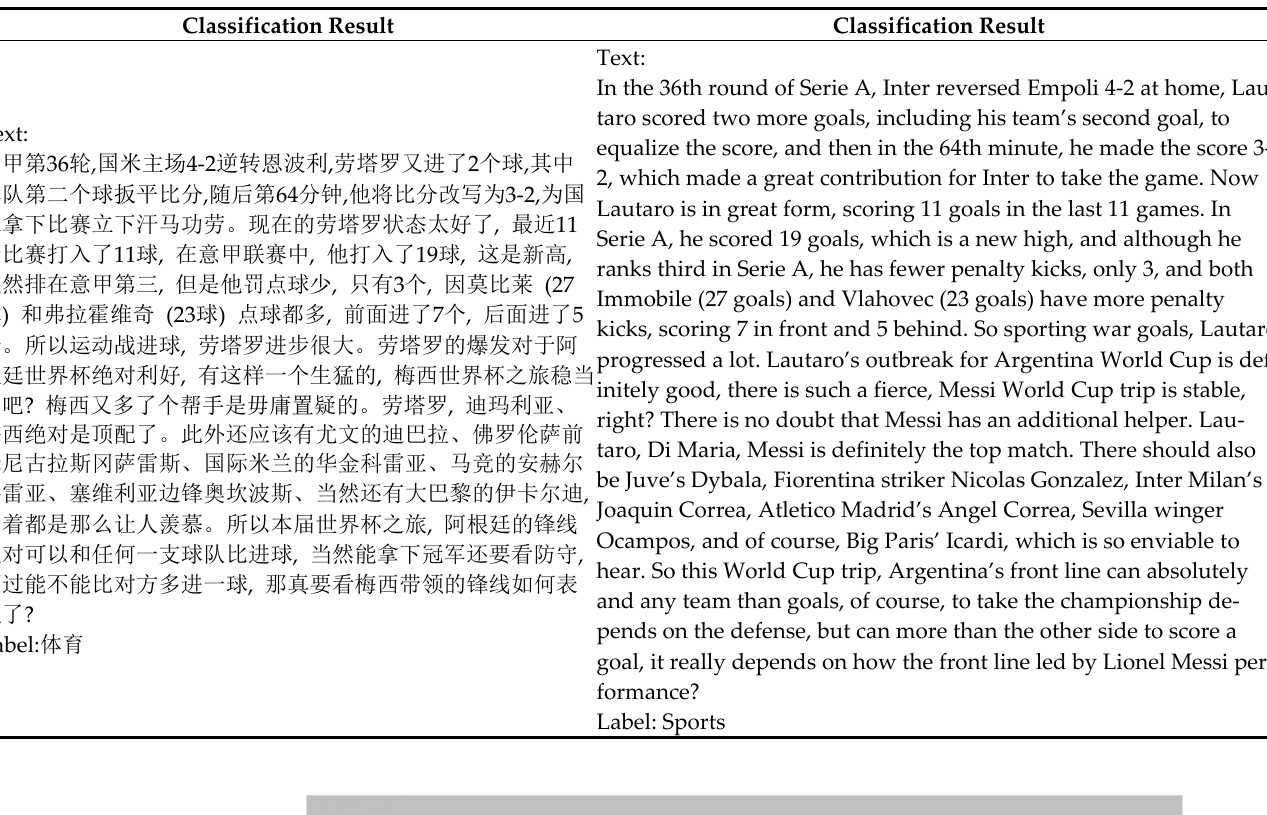
Table 3. Classification results for the THUCNews dataset (Chinese Expression).